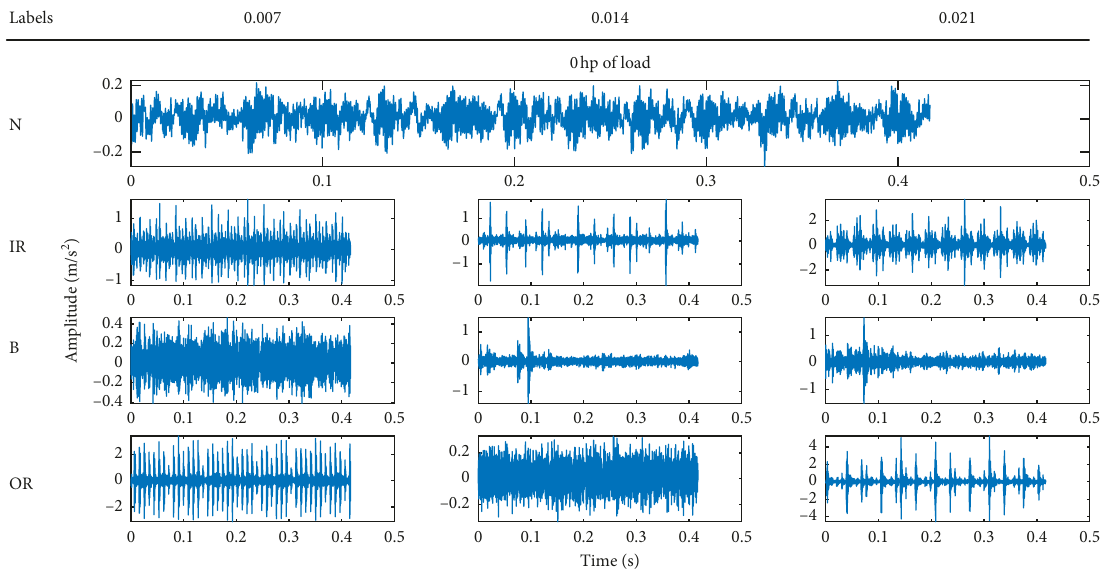
Figure 8: Time-domain graph of the original signal when the load is 0hp.